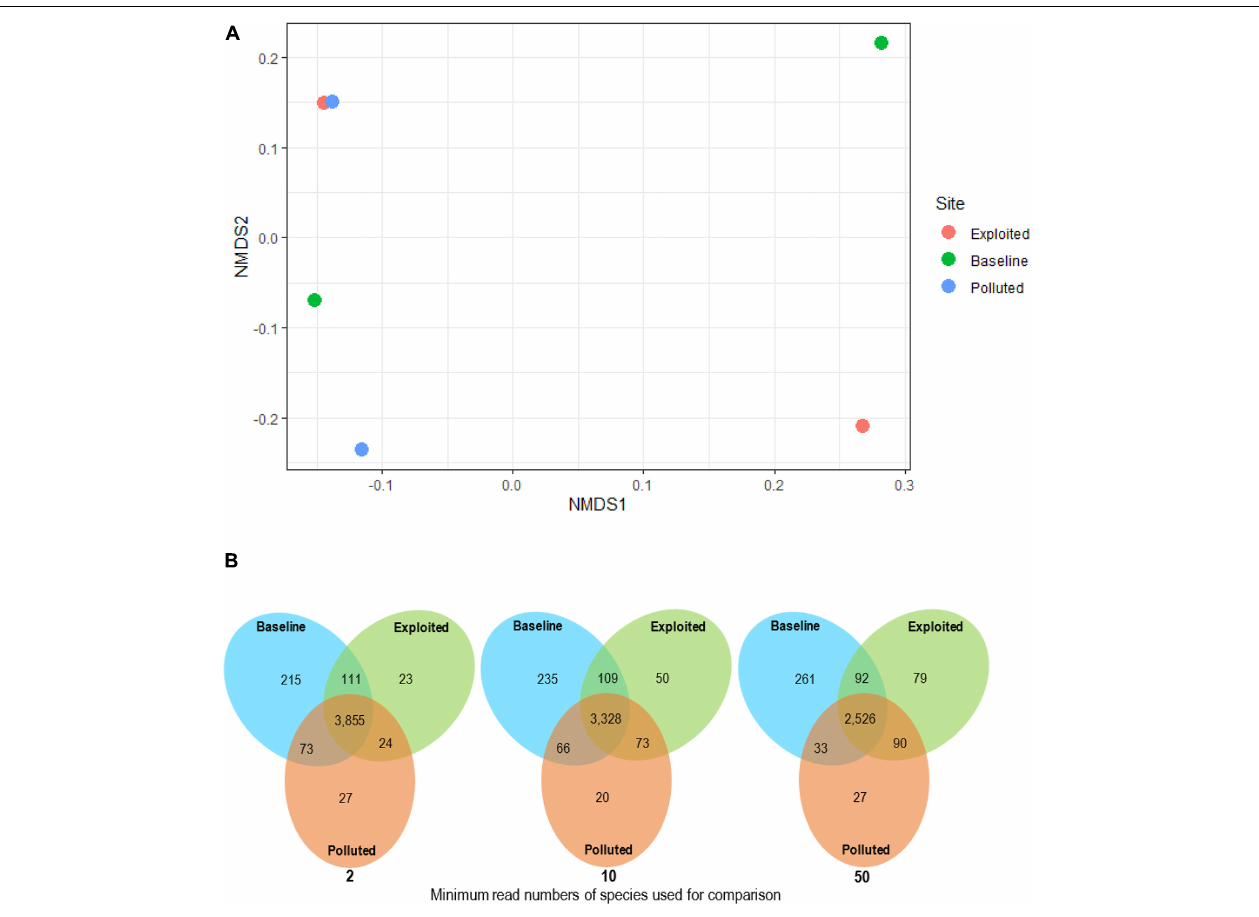
FIGURE 3 | (A) Bacterial community composition analyzed with non-metric multidimensional scaling (nMDS) plots using Bray-Curtis dissimilarity for near-coral seawater and sediment samples from Malindi (peach circle; exploited), Mombasa (aqua circles; polluted) and Kisite-Mpunguti (green circle; baseline) national marine parks. For this nMDS plot, stress = 0.05, r 2 = 0.998, and (B) venn diagrams showing the distribution of microbial species across study site metagenomes based on species with more than 2, 10, 50 reads.